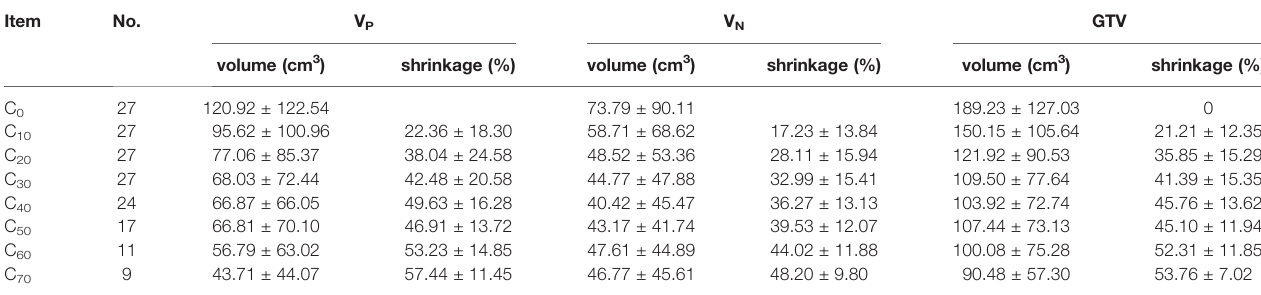
TABLE 3 | Changes in the gross tumour volume (GTV), primary tumour volume (V P ), and metastatic lymph nodes in drainage areas (V N ) at different times after targeted therapy in 29 patients (mean ± SD).